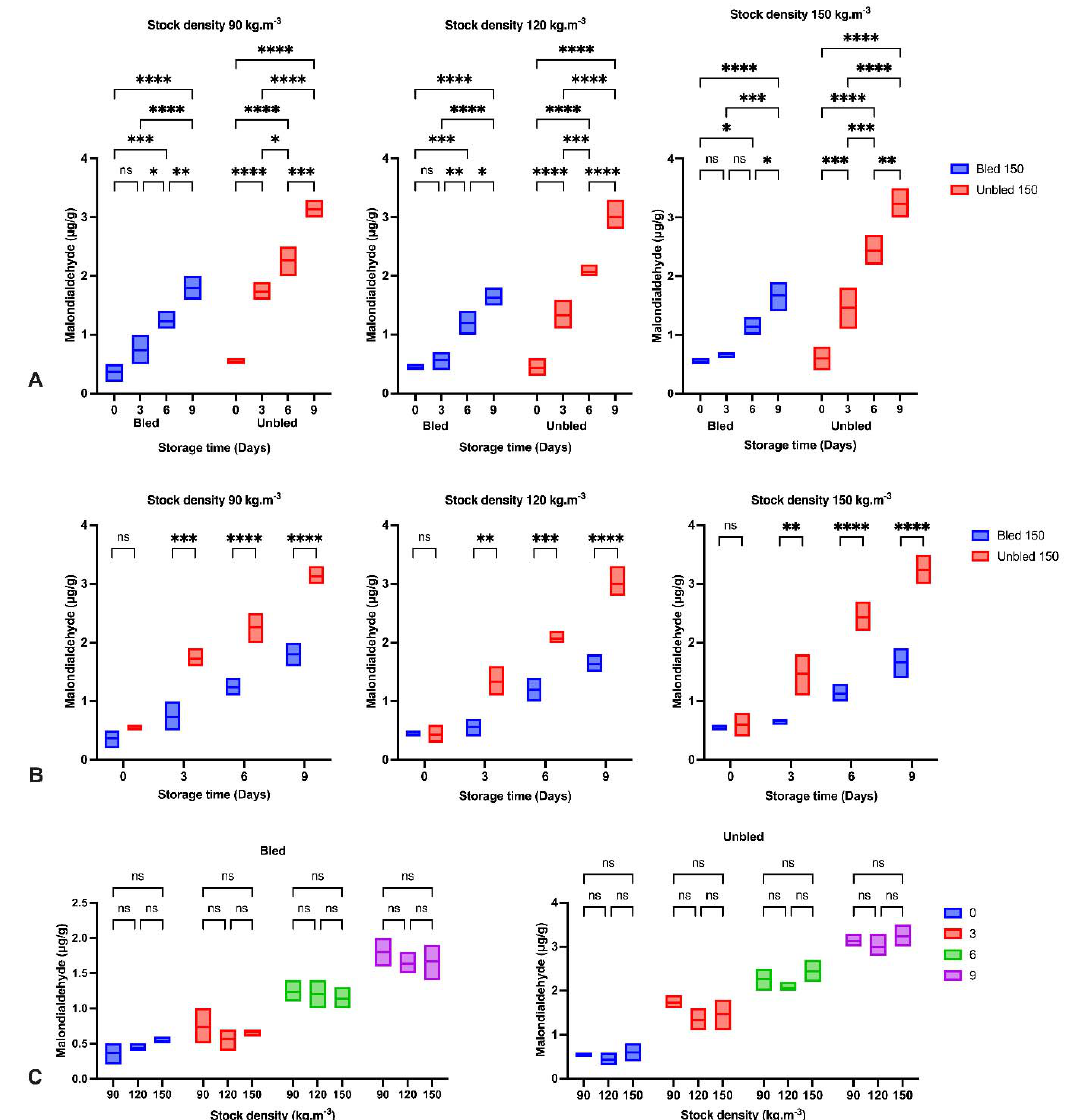
Figure 5. TBARS: ( A ) During the storage time (0, 3, 6 and 9 days) in bled and unbled groups at different stock densities (90, 120 and 150 kg · m − 3 ); ( B ) In bled and unbled groups at each storage time (0, 3, 6 and 9 days) and at different stock densities (90, 120 and 150 kg · m − 3 ); ( C ) In different stocking densities (90, 120 and 150 kg · m − 3 ) during storage time (0, 3, 6 and 9 days) in bled and unbled groups; ( p < 0.05, Tukey’s multiple comparisons test; ns: non-significant; * p < 0.05; ** p < 0.01; *** p < 0.001; **** p < 0.0001). Box plots showing line at mean. Box plots showing the line at upper quartile, lower quartile and at the